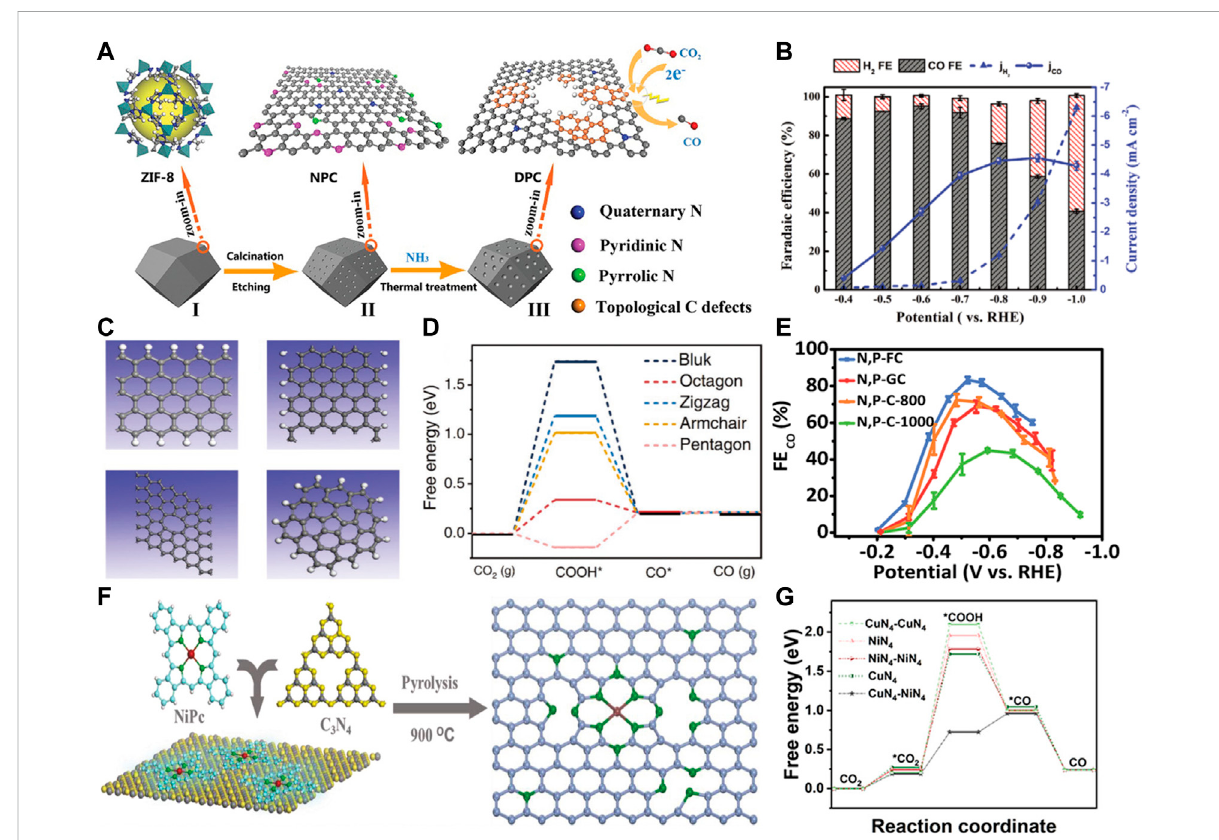
FIGURE 1 (A) Schematic illustration of the synthetic route of 3D topologically defected porous carbon particles. (B) Faradaic ef fi ciencies of CO (gray) and H 2 (red) and the partial current of CO on 3D topologically defected porous carbon particles under a range of applied potentials. [Reproduced from (Dong et al., 2020) with permission from the Royal Society of Chemistry]. (C) Defect models used for theoretical calculations: zigzag edge (upper left), armchair edge (upper right), octagonal (lower left), and pentagonal (lower right). (D) DFT calculations for CO 2 RR activities of different defects.[Reproducedwithpermissionfrom(Wangetal.,2019)]. (E) FEforCOproductionatdifferentappliedpotentials.[Reproducedfrom(Xueetal., 2019) with permission from the Royal Society of Chemistry]. (F) Schematic of the overall synthesis procedure of Ni-NG-900 catalyst. [Reproduced with permission from (Boppella et al., 2022)]. (G) Free energy diagram of the CO 2 RR process for CO production on various samples. [Reproduced with permission from (Hao et al.,